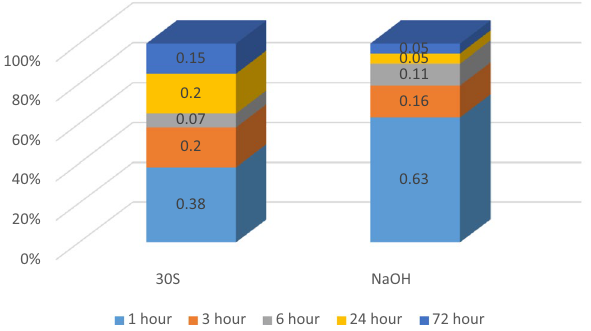
Fig. 15 The hourly/final ratio of capillary absorption coefficient for NaOH and 30S designs (28